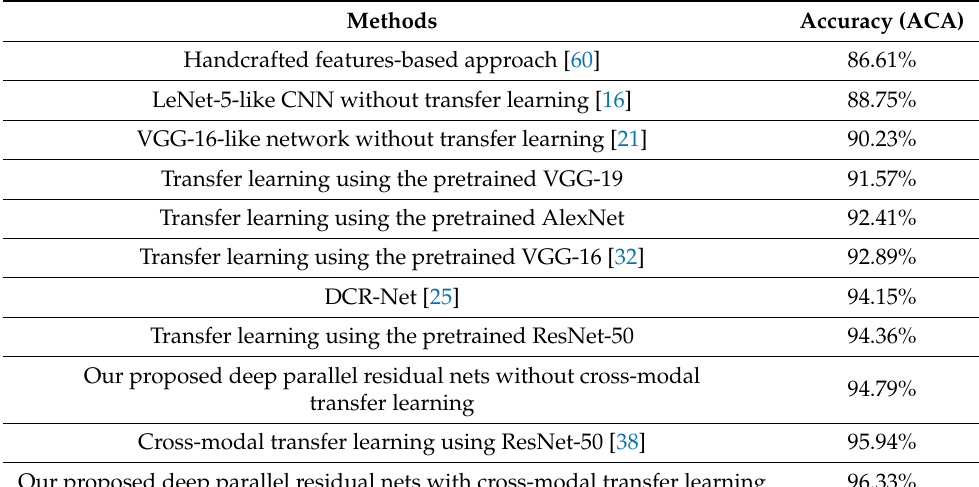
Table 3. Comparative study using the LSHEp-2